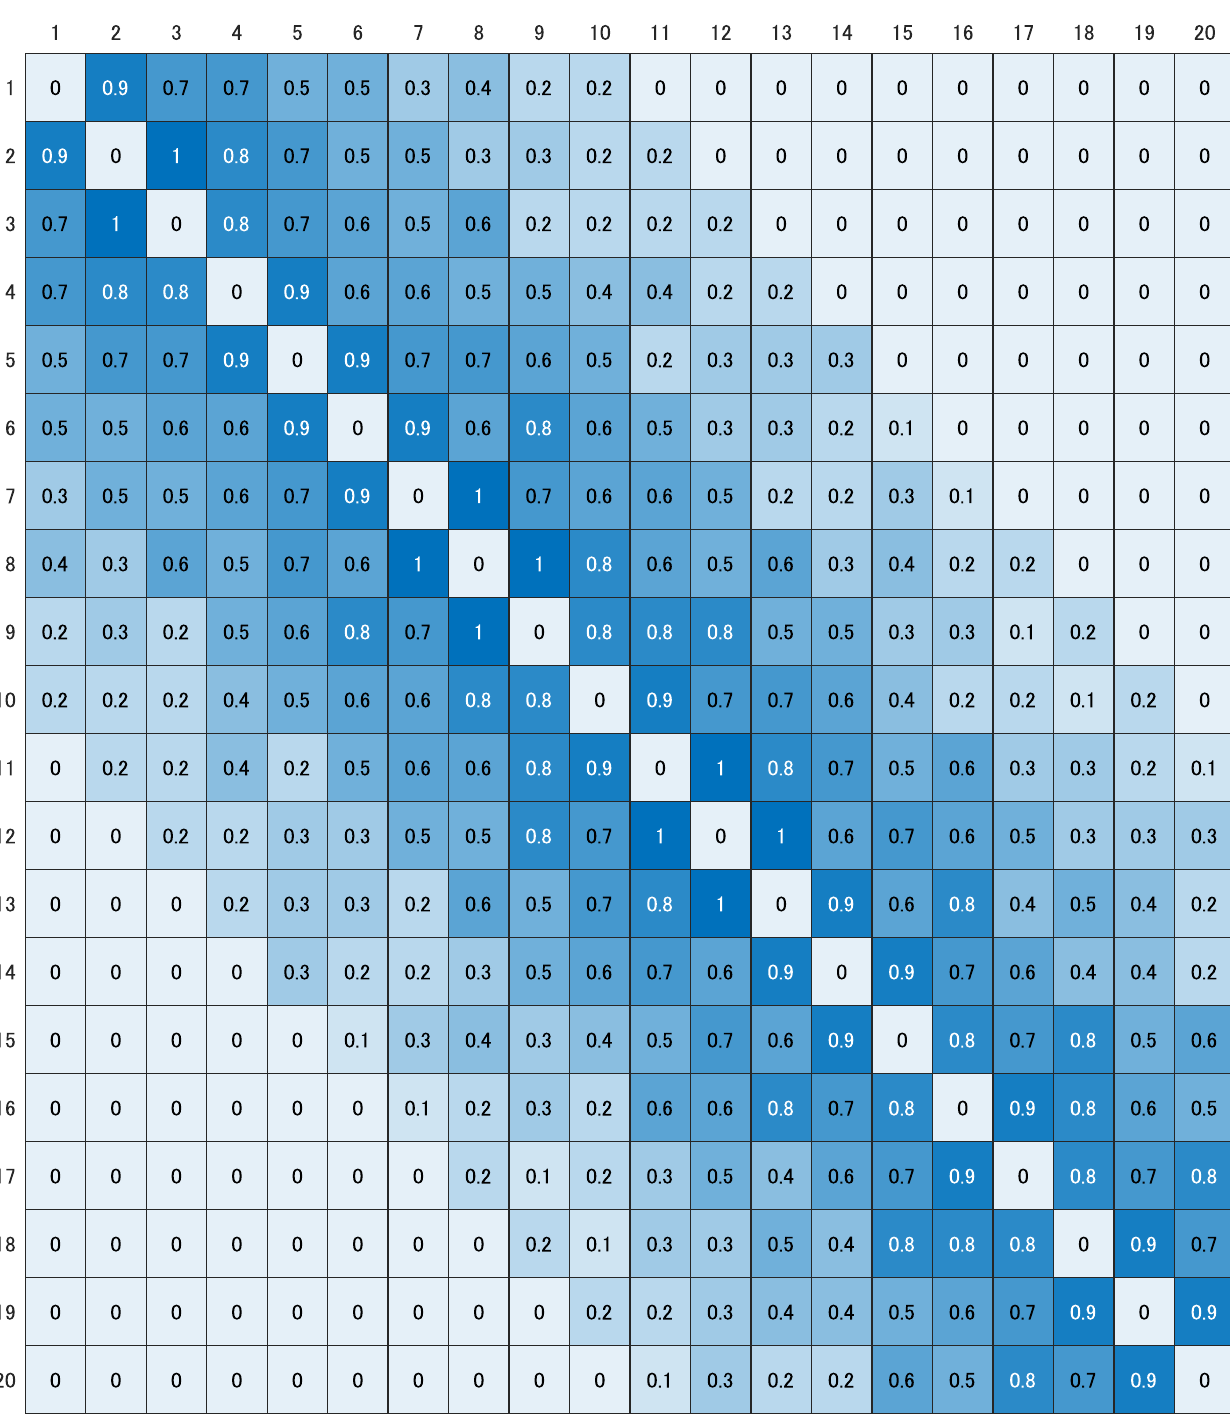
Figure A2. W q ∈ R 20 × 20 shown in heatmap